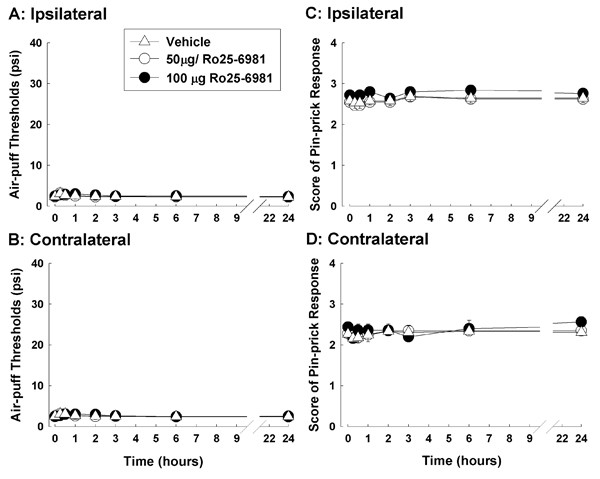
The antinociceptive effects of Ro25-6981 in rats with compression of the trigeminal nerve root. The effects of Ro25-6981, a selective NR2B antagonist, on mechanical allodynia (A, B) and hyperalgesia (C, D) in rats with compression of the trigeminal root (n = 8 in each treatment group). Neither the intracisternal administration of vehicle nor 50 or 100 μg of Ro25-6981 affected the air-puff thresholds on both the ipsilateral (A) and contralateral (B) sides. Moreover, injections of 50 or 100 μg of Ro25-6981 did not affect pin-prick scores on either side (C, D).